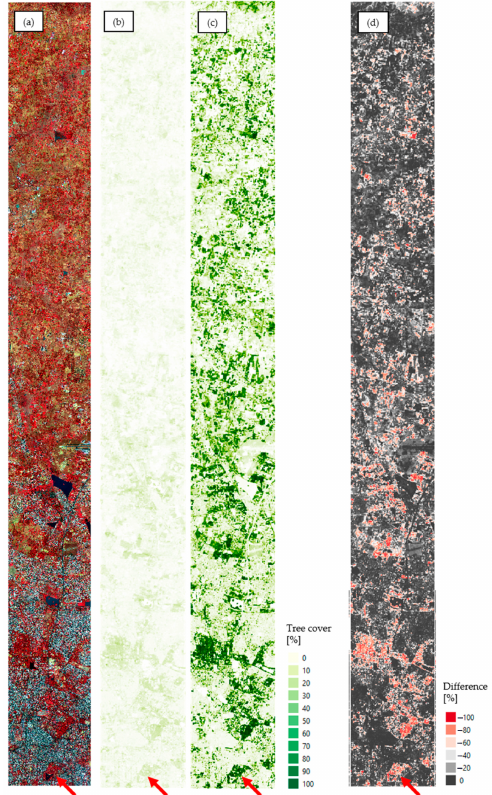
Figure 4. ( a ) WorldView-3 false color composite (near infrared-red-green) from a subset of the study area. ( b ) Percent tree cover per pixel from the Global 30 m Landsat Tree Canopy Version 4 [13]. ( c ) Percent tree cover per pixel from Landsat-8 in our study. Legend is the same for ( b , c ). ( d ) Difference map: “global tree cover” ( b ) minus “our predicted product” ( c ).